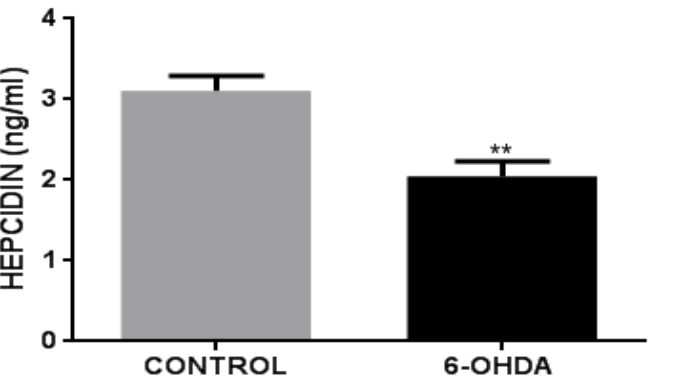
Figure 4. Amount of hepcidin release in 6-OHDA-induced BV2 cells. Hepcidin release was reduced in BV2 cells when treated with 6-OHDA compared with that of the control group. n = 6. ** p < 0.01, compared with the control group.